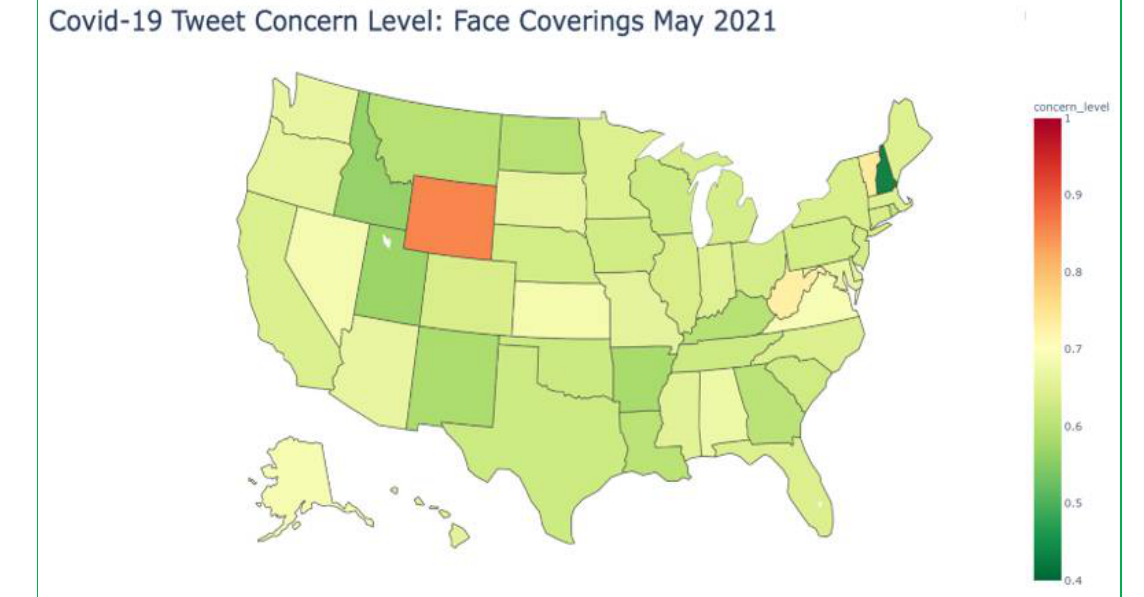
Figure 4. Concern Levels by State for Face Coverings in May 2021.